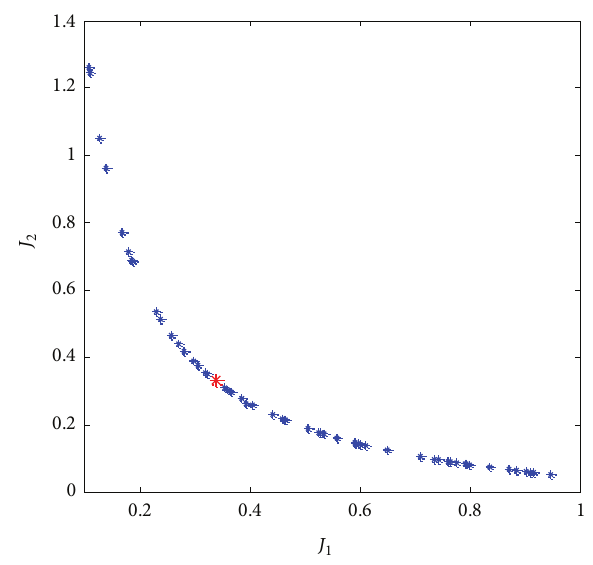
Figure 2: The Pareto-optimal solutions.